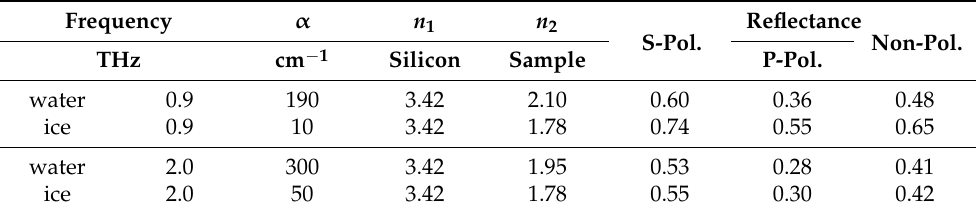
Table 1. A sample of the n and α combinations at 0.3 THz and 1.0 THz which deliver the same reflected signal intensity at 45 ◦